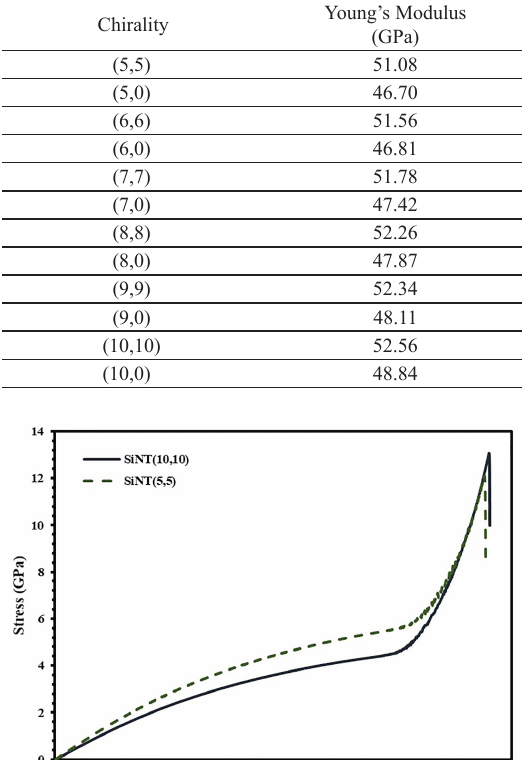
Table 1. Elastic modulus of (5,5) SiNT with length of 5 nm.